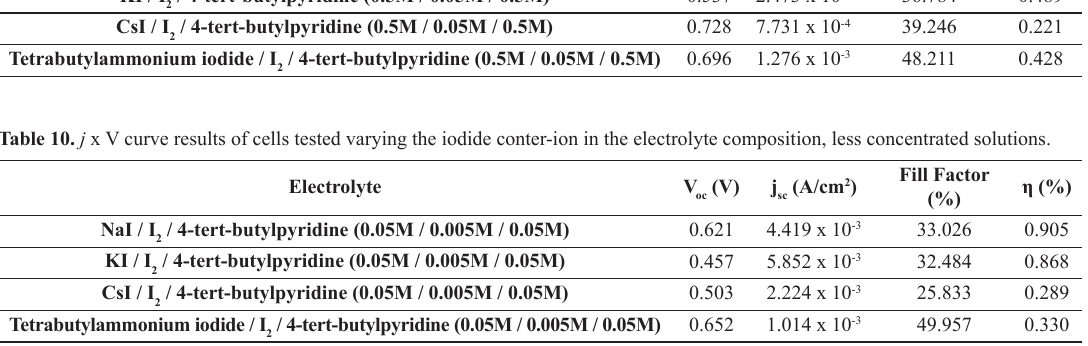
Table 9. j x V curve results of cells tested varying the iodide counter-ion in the electrolyte composition. Electrolyte